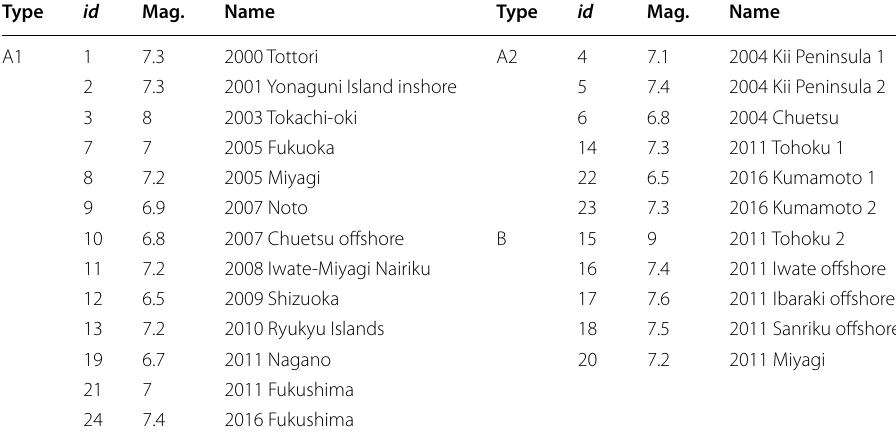
Table 2 Classification labels for the 24 major earthquakes